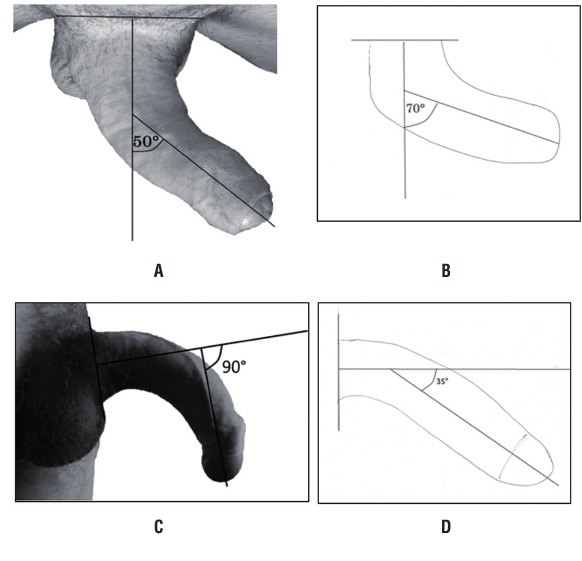
figure 1 - Example of overestimation of the penile curvature in a patient with pD. Objective measurement of the degree of penile curvature was performed on standardized photograph (A) and on the drawing; (B) of the same penis during erection using two intersecting lines. On the other hand, the drawings underestimate the curvature in a case of congenital penile deviation (c,